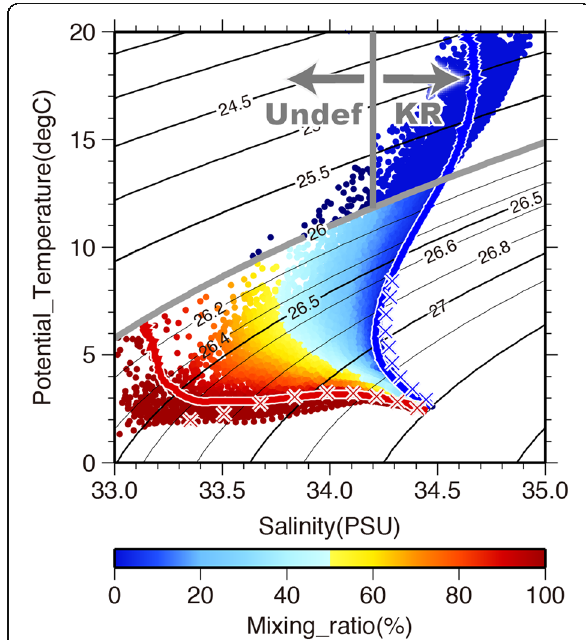
Fig. 4 Profiles of the current pure Oyashio waters (blue) and Kuroshio waters (red) that were estimated by using FORA-WNP temperature and salinity data. Color shade represents the Oyashio mixing ratio. Blue (red) crosses denote the pure Oyashio (Kuroshio) waters profiles estimated by observation data (Yasuda et al. 2001). We defined the mixing ratio below 26.0 σ θ as 0% or undefined by